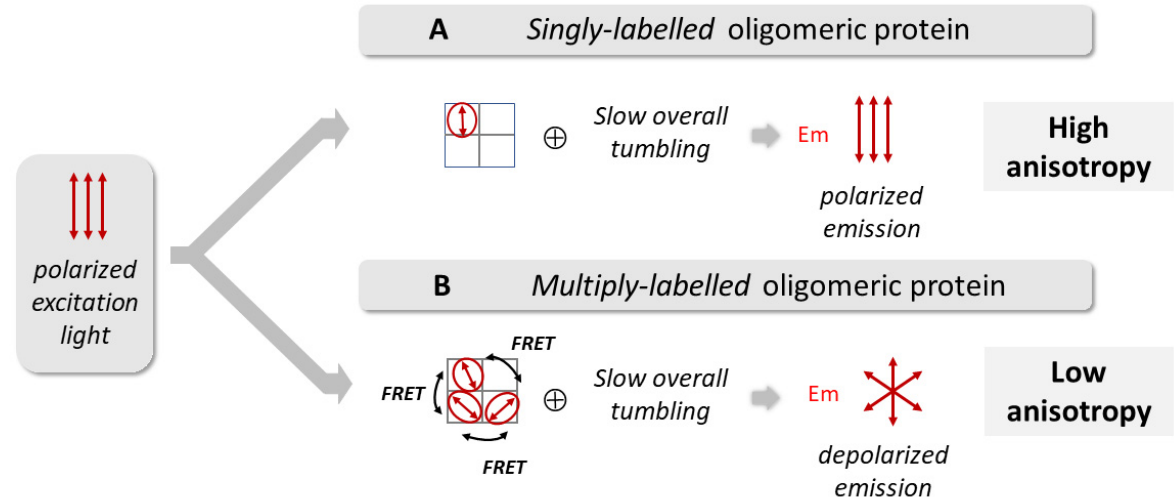
Figure 2. The degree of protein labelling strongly influences the steady-state fluorescence anisotropy of a homo-oligomeric protein due to the possible occurrence of an intramolecular homo-FRET process in the multiply labeled species. The experimental readout used to detect the occurrence of FRET among identical fluorophores with a small Stoke shift (homo-FRET) is the steady-state fluorescence anisotropy of the sample, < r >. This requires the performance of polarized fluorescence measurements whereupon the sample is excited with vertically polarized light and the parallel and perpendicular components of the emitted fluorescence are used to compute < r > (Equation (2)). ( A ) At a low degree of protein labelling, the predominant labeled species in solution is the singly labeled homo-oligomeric protein. In this case, the main factor responsible for the depolarization of the emitted fluorescence is the slow overall tumbling of the protein in solution over time, and therefore the fluorescence anisotropy, < r >, is very high. ( B ) However, at a high degree of protein labelling, a heterogeneous population of multiply labeled species is present in solution. When the multiple fluorophores attached to a single protein are in close proximity, successive intramolecular FRET steps (energy migration) among the conjugated dyes are highly probable. This leads to a strong FRET-induced angular displacement (depolarization) of the emitted fluorescence, which results in a pronounced decrease of the sample fluorescence anisotropy, < r >.